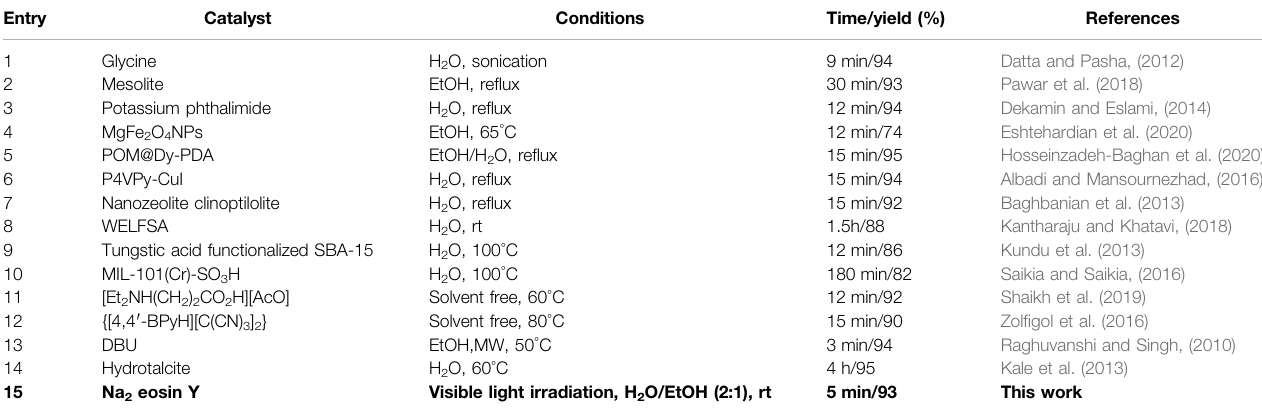
TABLE 3 | Comparison between the catalytic capacity of some catalysts in this work a